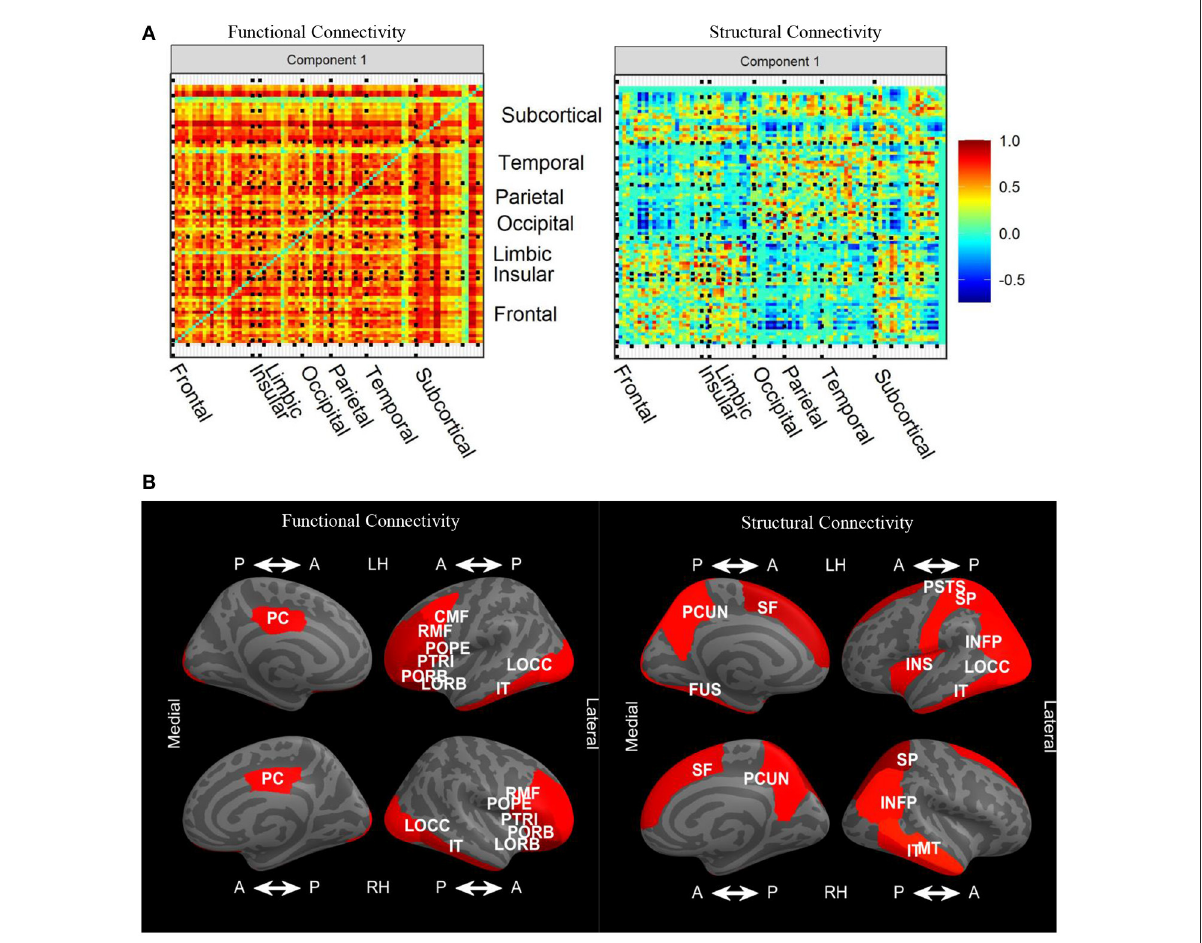
FIGURE6 (A) Variable loadings for the first component of the joint signal space estimated by CJIVE and displayed on heatmaps. (B) Displays the top 25 th percent of L1 norms of the variable loadings related to each cortical ROI for joint component 1. CMF, caudal middle frontal; FUS, fusiform; INFP, inferior parietal; IT, inferior temporal; INS, insula; LOCC, lateral occipital; LORB, lateral orbito-frontal; MT, middle temporal; PCUN, precuneus; PSTS, postcentral; PC, posterior cingulate; POPE, pars opercularis; PORB, pars orbitalis; PTRI, pars triangularis; RMF, rostral middle frontal; SF, superior frontal; SP, superior